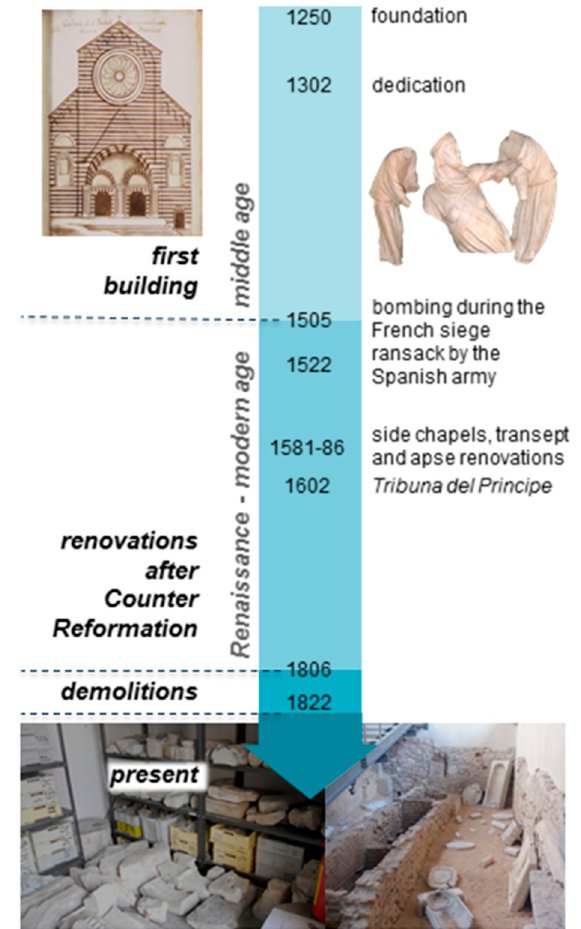
Figure 1. Timeline indicating the major events involving the long-lost monastic complex. Its three main life phases (construction, renovations, dismantling) are evidenced. Photographic reproduction of the drawing of the façade, courtesy of the Berio Library, Genoa, and photography of the repository, courtesy of the Superintendence of Archaeology, Fine Arts and Landscape for the metropolitan city of Genoa and the provinces of Imperia, La Spezia and Savona (partial or total reproduction is forbidden without prior (written) permission).